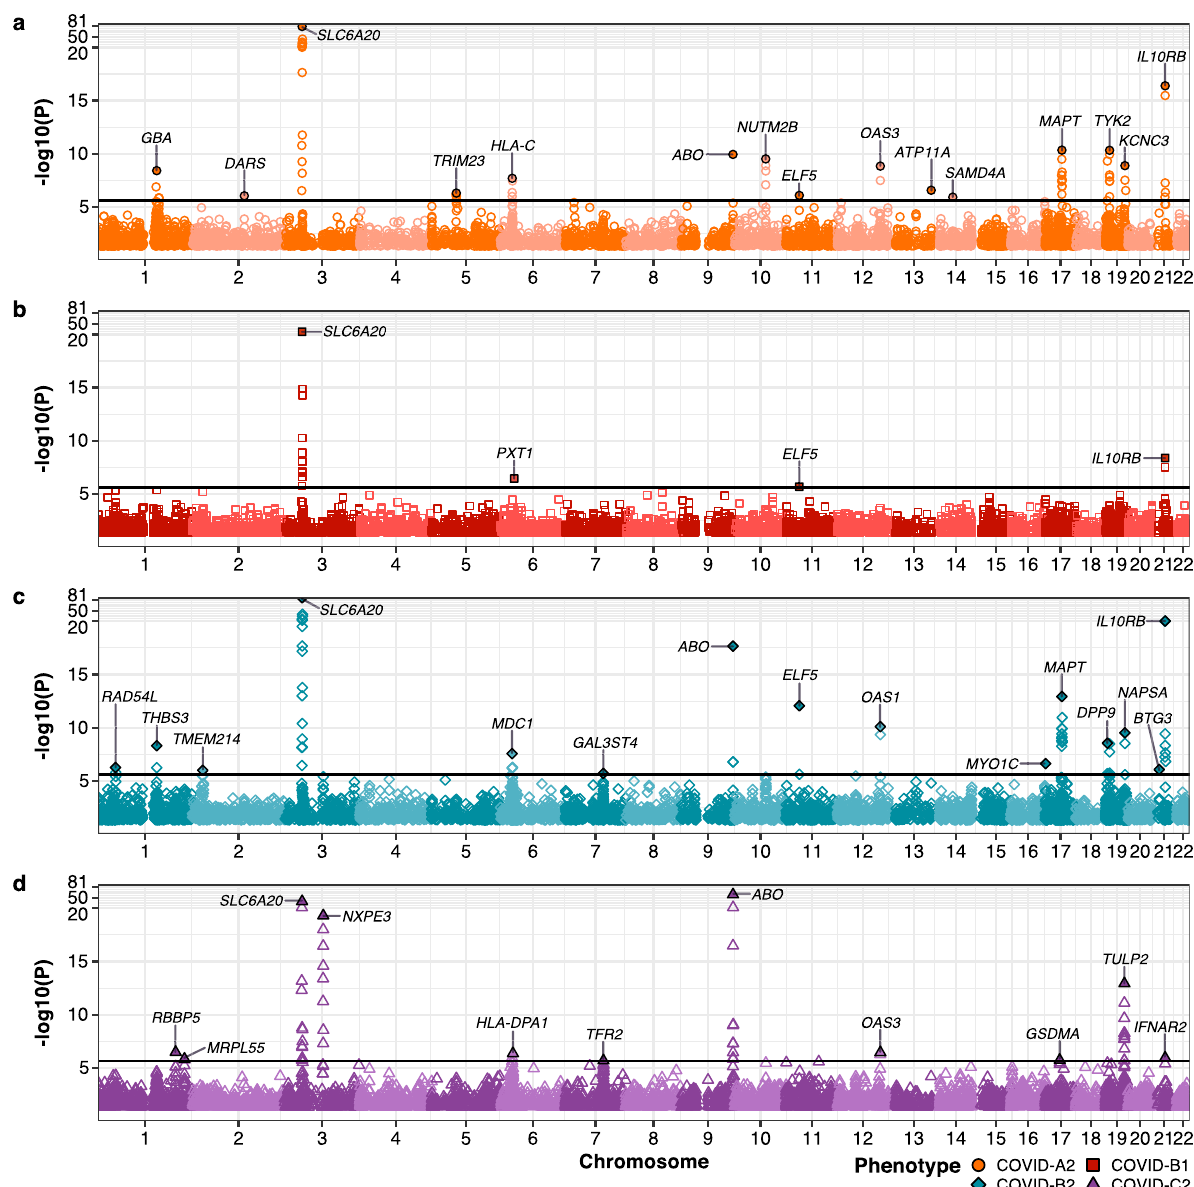
Fig. 7 TWAS Manhattan plot for COVID-19-related outcomes via PUMICE + . a – d illustrates the Manhattan plot for ( a ) COVID-A2, ( b ) COVID-B1, ( c ) COVID-B2, and ( d ) COVID-C2. Black horizontal line marks the genome-wide signi fi cance threshold at 2 : 5 ´ 10 (cid:2) 6 (Bonferroni threshold corrected for 20,000 genes). The most signi fi cant genes at each phenotype-locus pair are labelled. Two-sided P value associated with each gene is calculated according to the TWAS Z-score for gene-based association